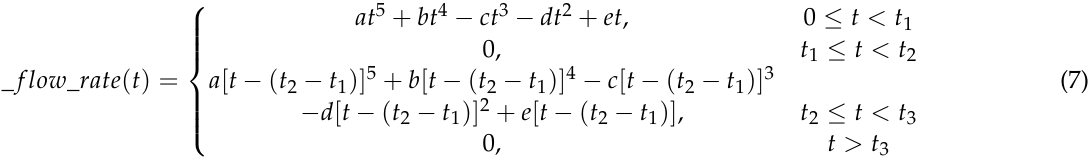
Figure 5. Schematic diagram of CFD model development for the droplet injection process. The 3D chamber model’s main function is to simulate the process of deformation movement of the PZT membrane and obtain the ink mass-flow curve in the chamber, which is used as the boundary input condition of the 2D nozzle-air domain model. When the numerical simulation model was established, the PZT membrane was set as the moving mesh. The DEFINE_GRID_MOTION macro function of the UDF method was used to drive the motion deformation of the membrane. The DEFINE_ADJUST macro was used to record the change in the cross-sectional area of the chamber, and the mass-flow curve of the flowing ink was calculated by the DEFINE_EXECUTE_AT_END macro. The other boundary conditions were set as WALL. During this simulation, the ink mass-change value in the chamber was recorded, and a mass-flow curve using Equation (7) was ob- tained.